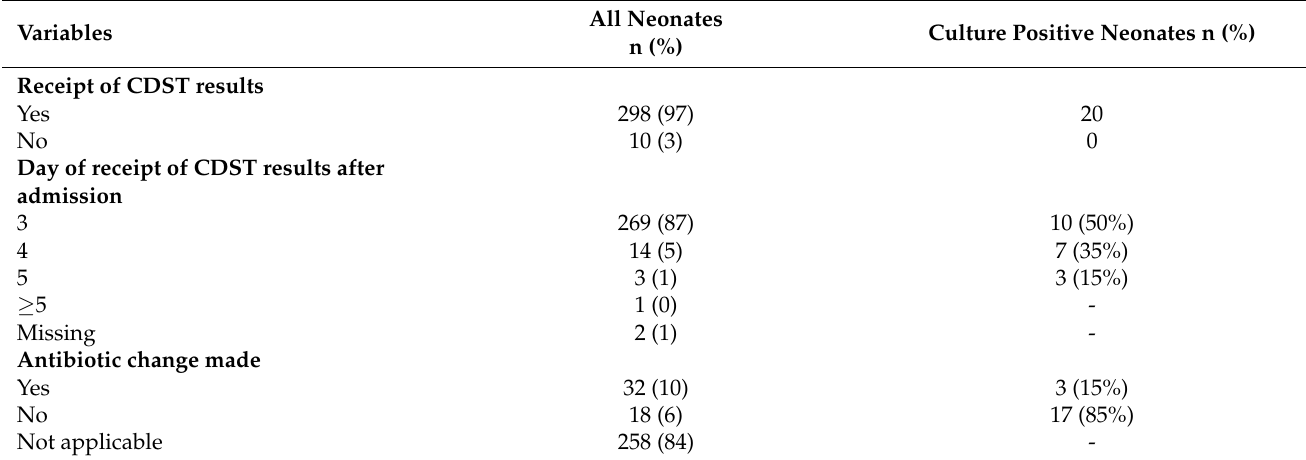
Table 2. Turn-around time of CDST and change in antibiotic after CDST results among neonates with clinically suspected sepsis admitted to NICU at KIST MCTH, Kathmandu Valley, Nepal during 2018–2019.